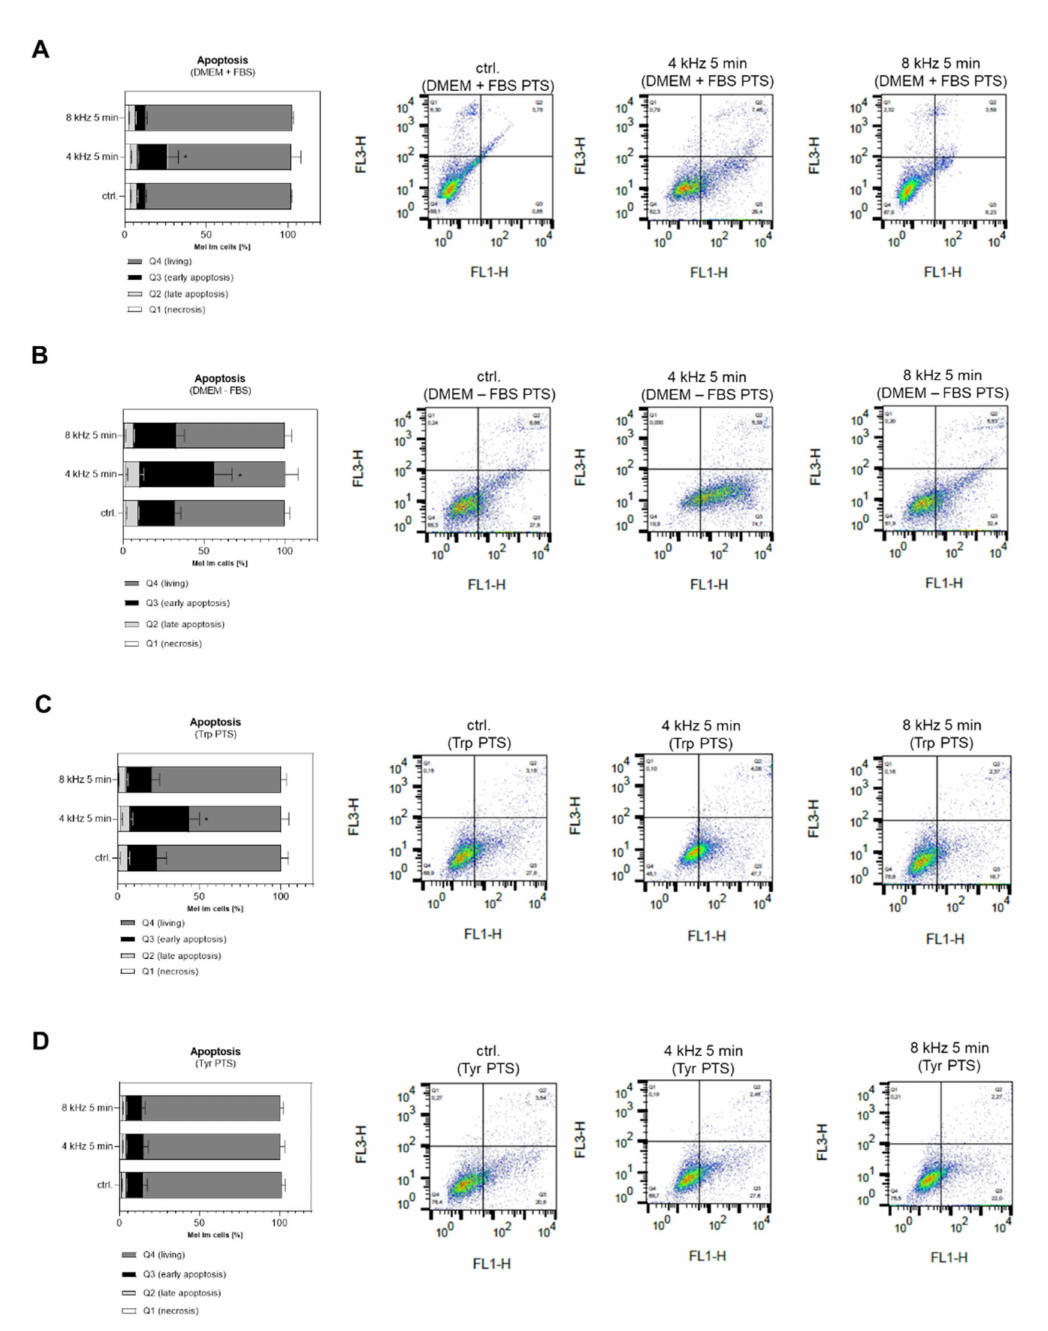
Figure 8. Apoptosis analysis in Mel Im melanoma cells after treatment with PTS. Necrosis (Q1), late apoptosis (Q2),